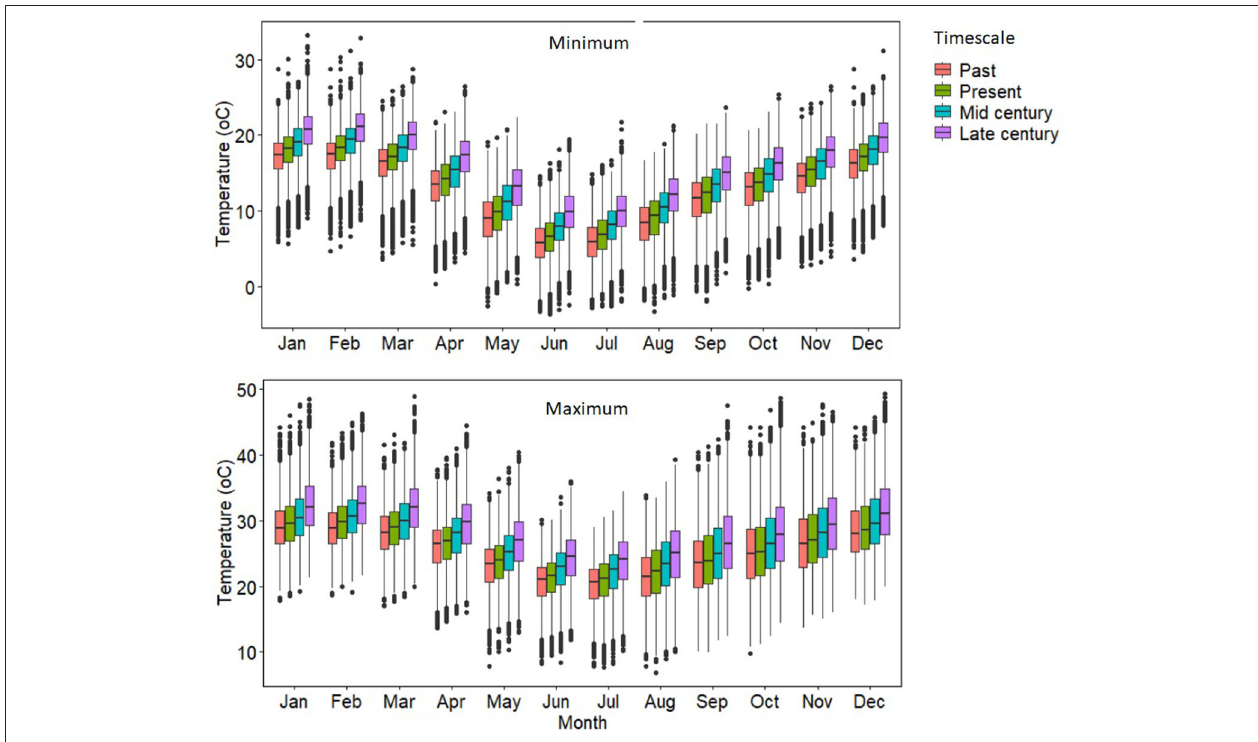
FIGURE 2 | Distribution of average monthly minimum (A) and maximum (B) temperature data for the different timescales (past, present, mid-, and late-century) as simulated by the six GCMs (ACC, CSS, CNR, GFD, NOR, and